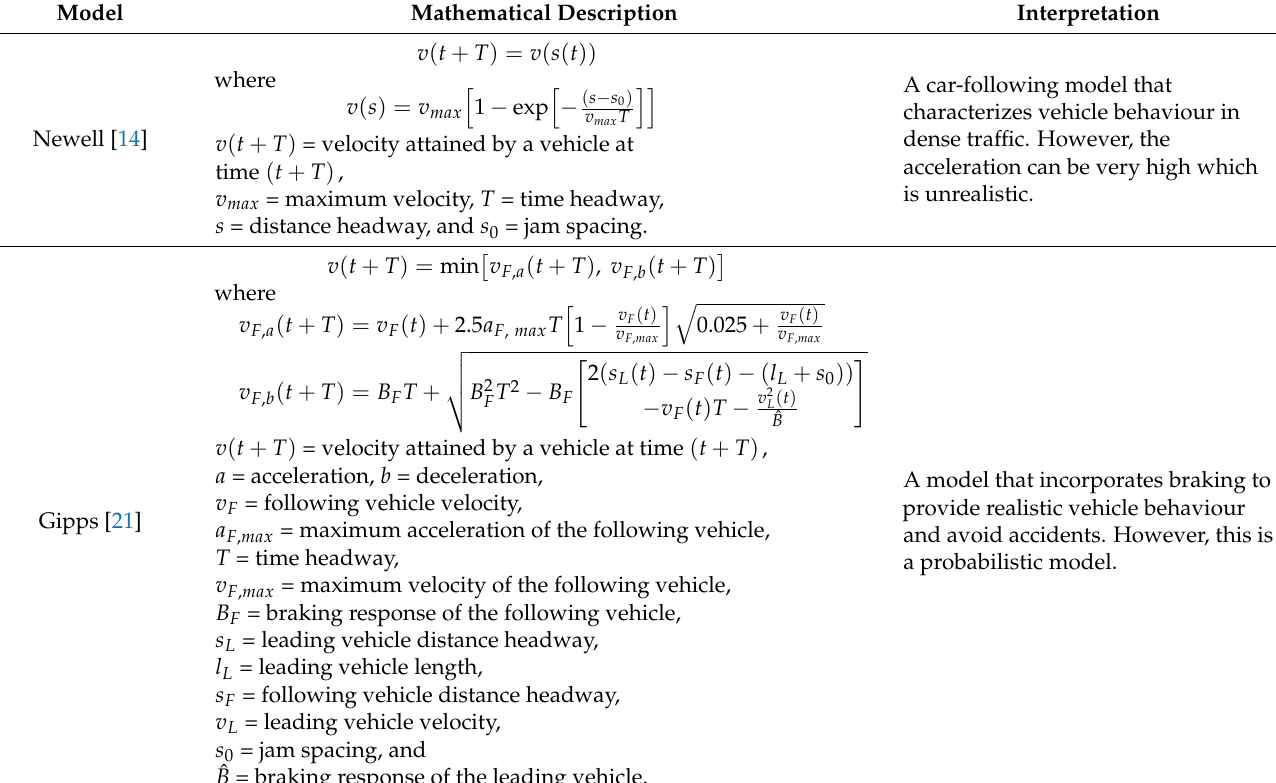
Table 1. Comparison of traffic